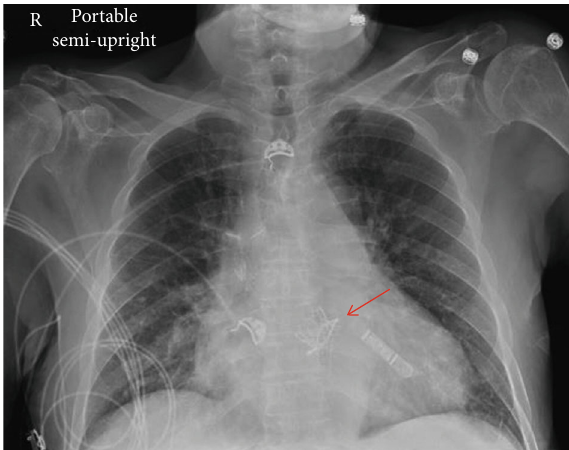
Figure 3: Chest X-ray (CXR): there are mildly increased interstitial markings (chronic in character), cardiomegaly, and no evidence of consolidation or pleural e ff usion. Loop monitor can be visualized in the CXR at the left lower chest wall as well as a valve-in-valve TAVR (red